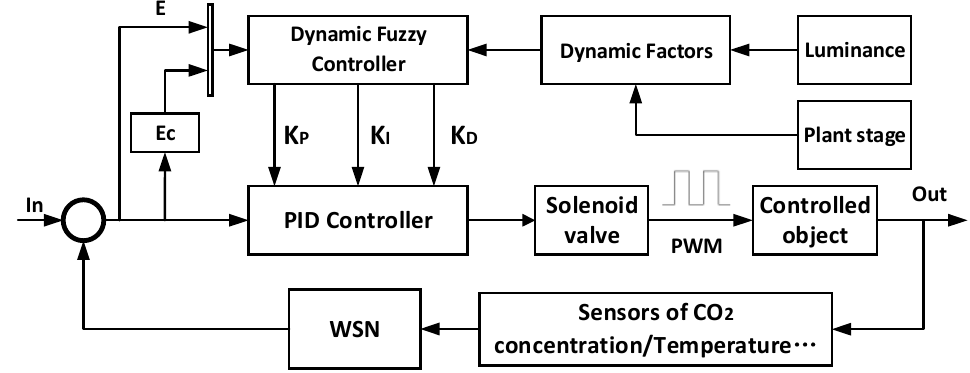
Figure 4. The diagram of the FLC (Fuzzy logic controller) for CO 2 concentration regulation.